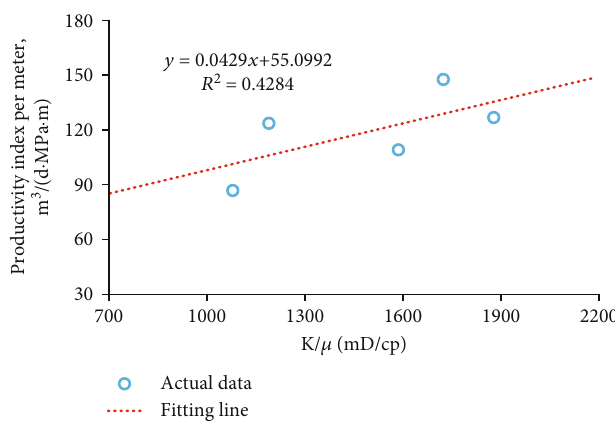
Figure 6: Relationship between transient productivity index per meter and